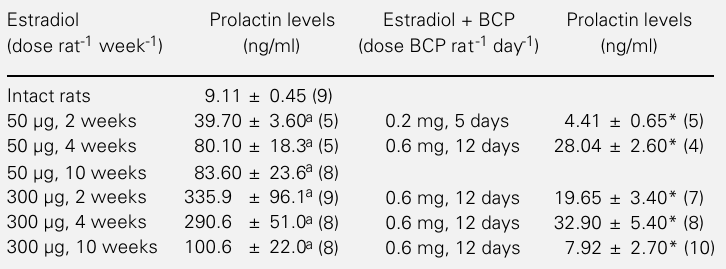
Table 2 - Serum prolactin levels of intact or ovariectomized rats treated with estradiol valerate alone or in combination with bromocriptine. Results are reported as mean – SEM. The number of animals is given in parentheses. BCP, Bromocriptine. a P<0.05 versus intact rats (Duncan(cid:146)s test); *P<0.05 versus estradiol ( t